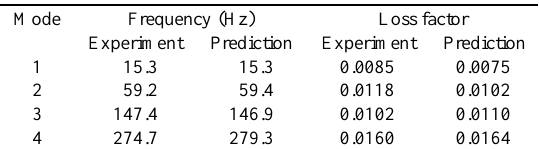
Fig. 8. loss factor and frequency. Table 1 Frequencies and loss factors